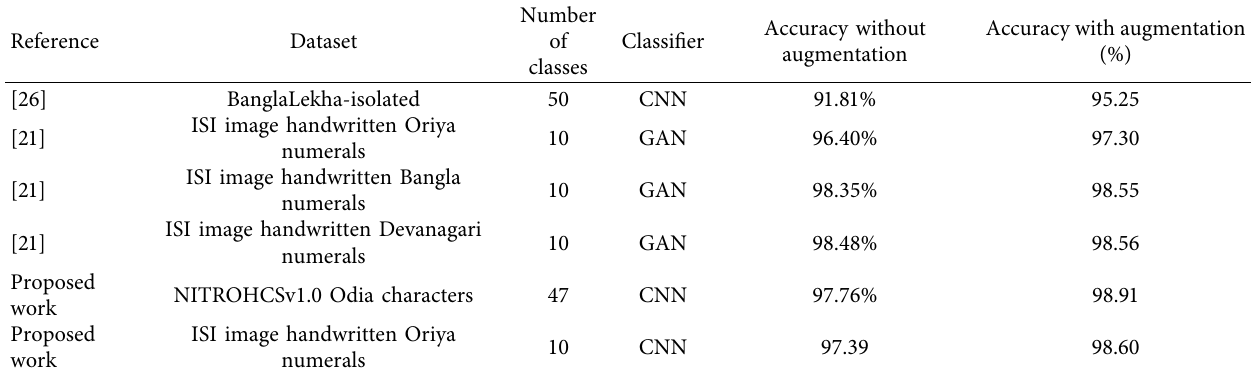
Table 12: Performance comparison of data augmentation techniques.